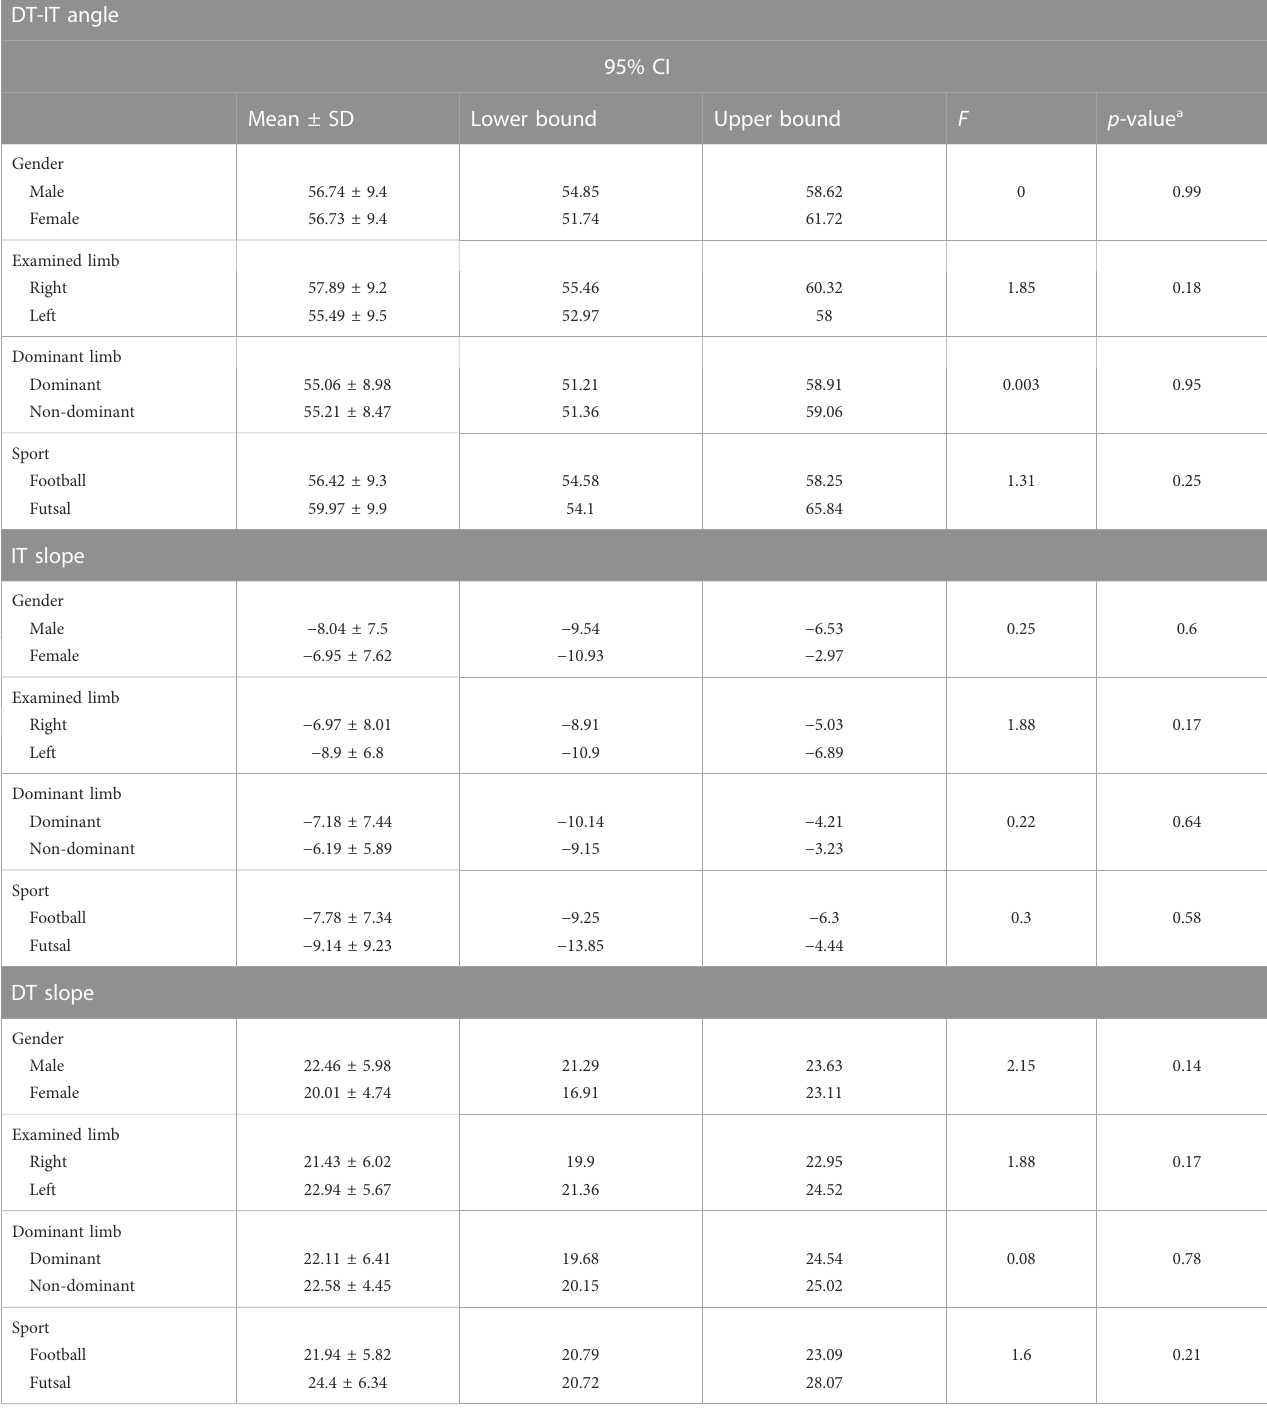
TABLE 5 One-way ANOVA test of the DT-IT angle, IT slope, and DT slope measured by observer 1 depending on the demographic factors, including 95% con fi dence interval (CI) and F -Fisher. DT-IT angle 95% CI Mean ± SD Lower bound Upper